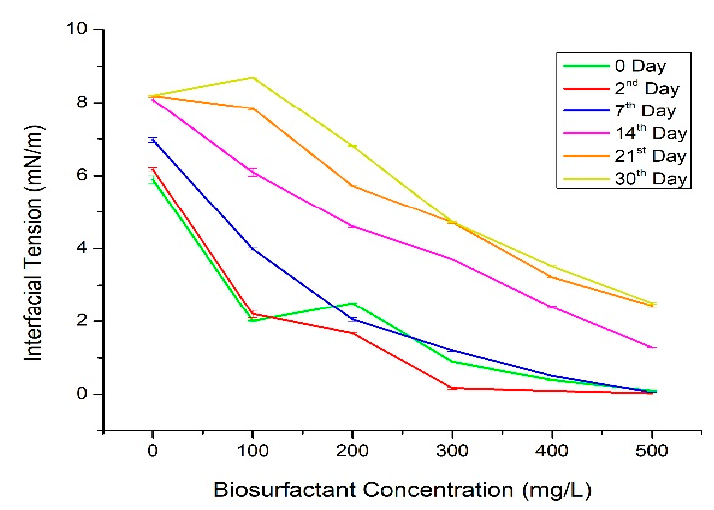
Figure 8. Measurement of interfacial tension at di ff erent biosurfactant concentrations in water at di ff erent temperatures.